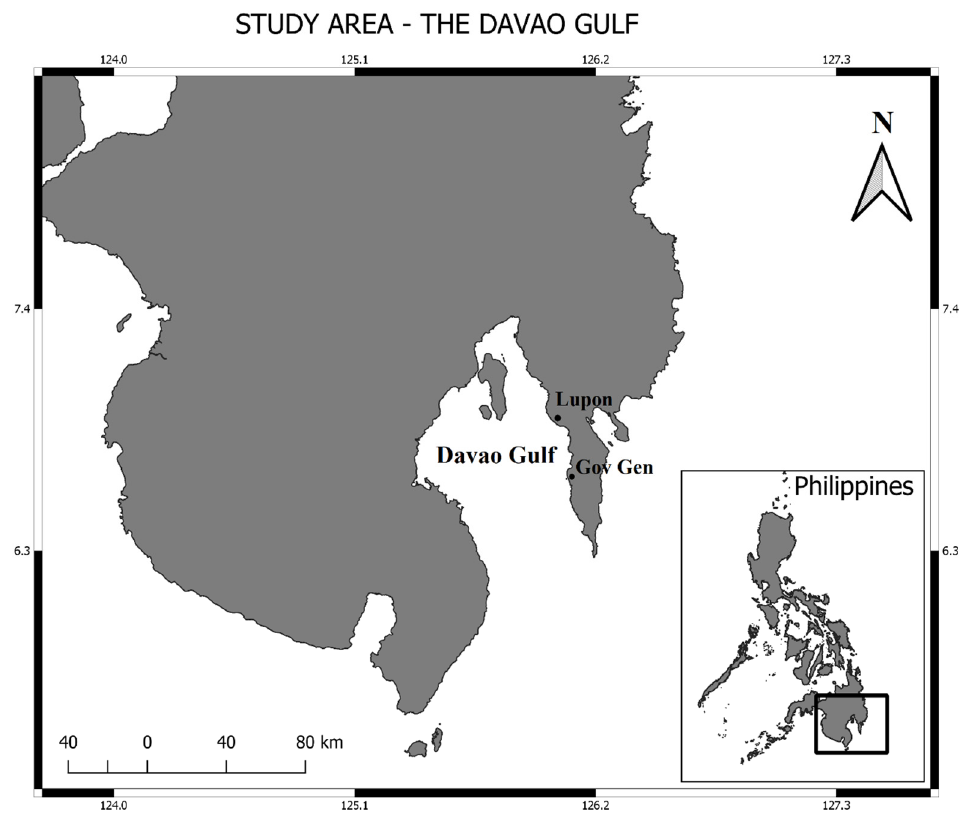
Figure 1. Map of the study sites Lupon and Governor Generoso in Davao Gulf, Philippines.